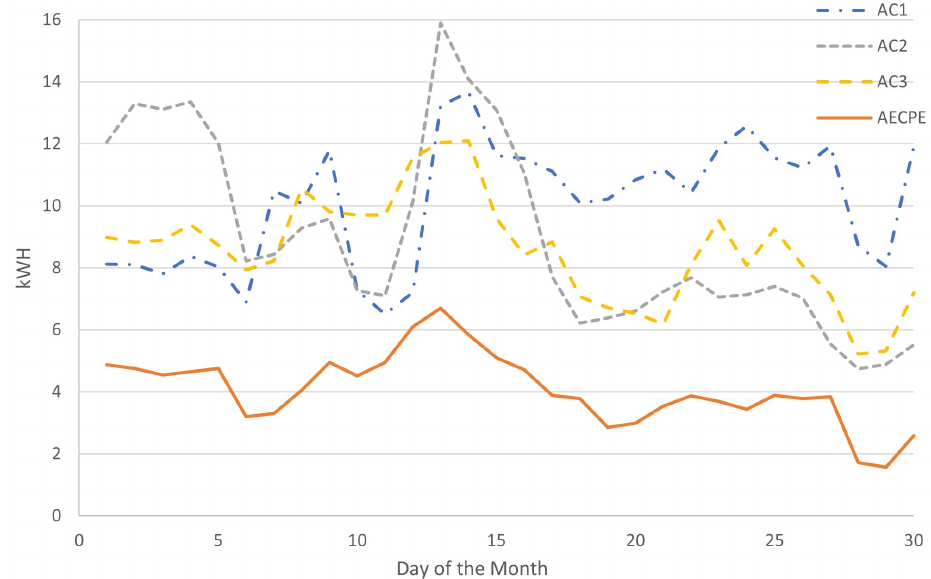
Figure 6. April results from the field